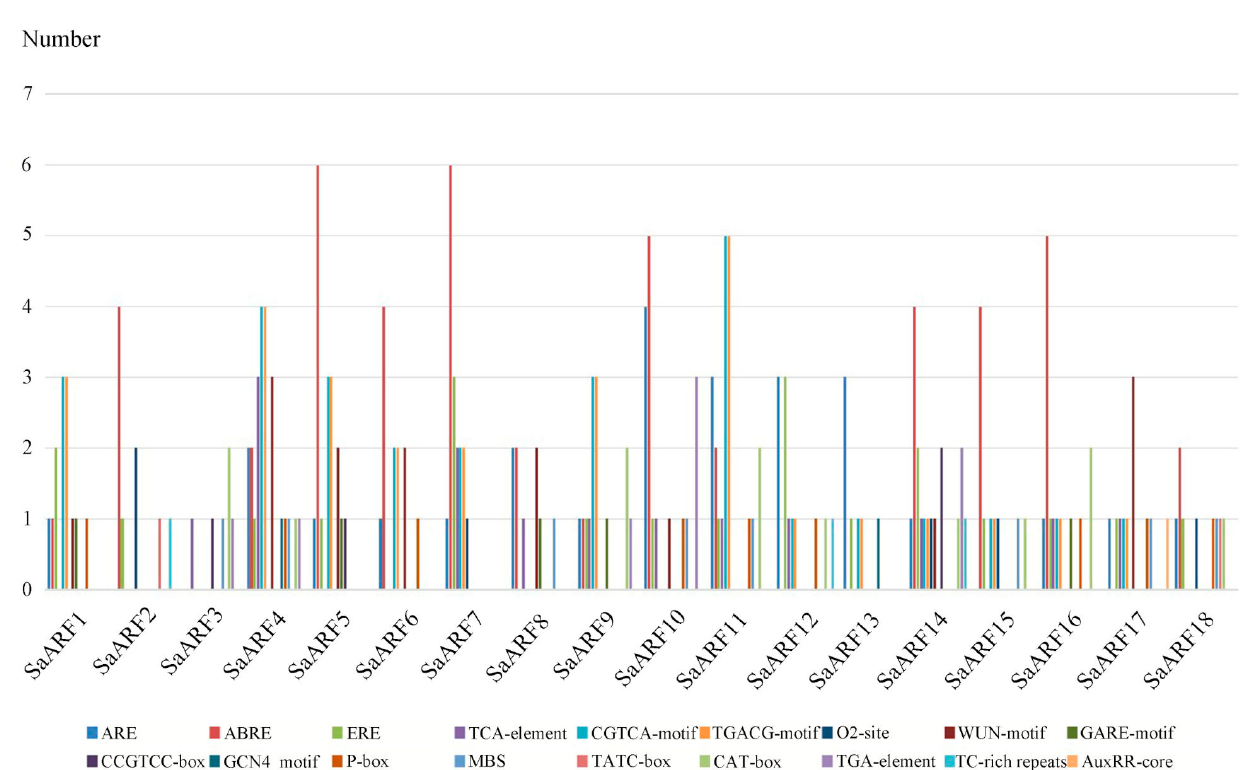
Figure 9. The number of cis-reactive elements of ARF